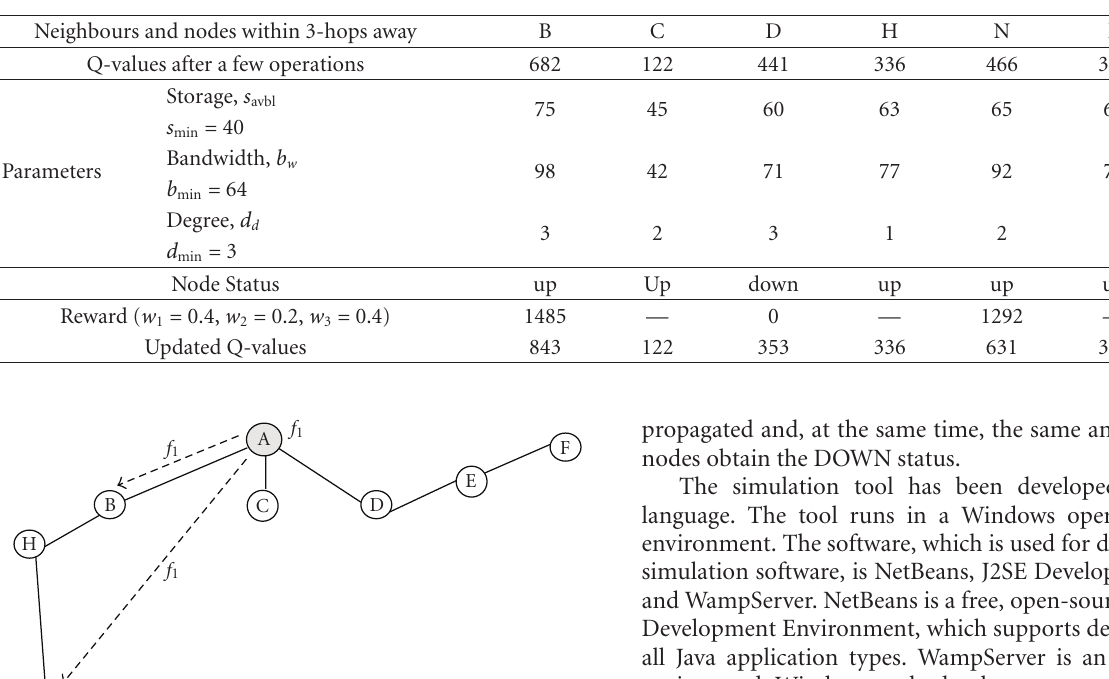
Table 4: Status of Q-table of node “A” before and after replication.